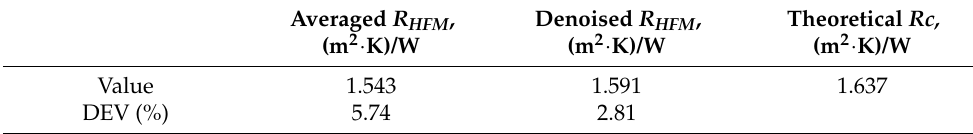
Table 6. The deviation of R HFM from the theoretical Rc -value. Averaged R HFM , (m 2 ·